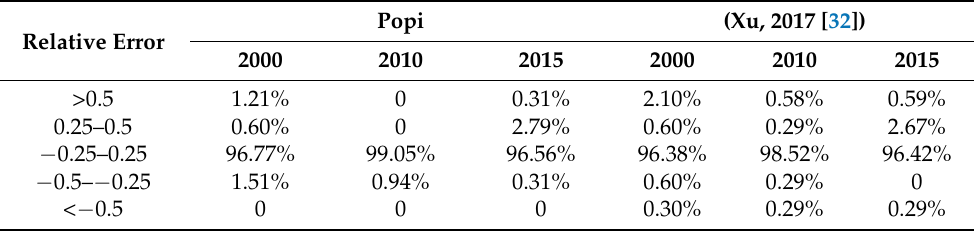
Figure 10. The relative error of population density data and census. Table 8. The relative error between the population density data and